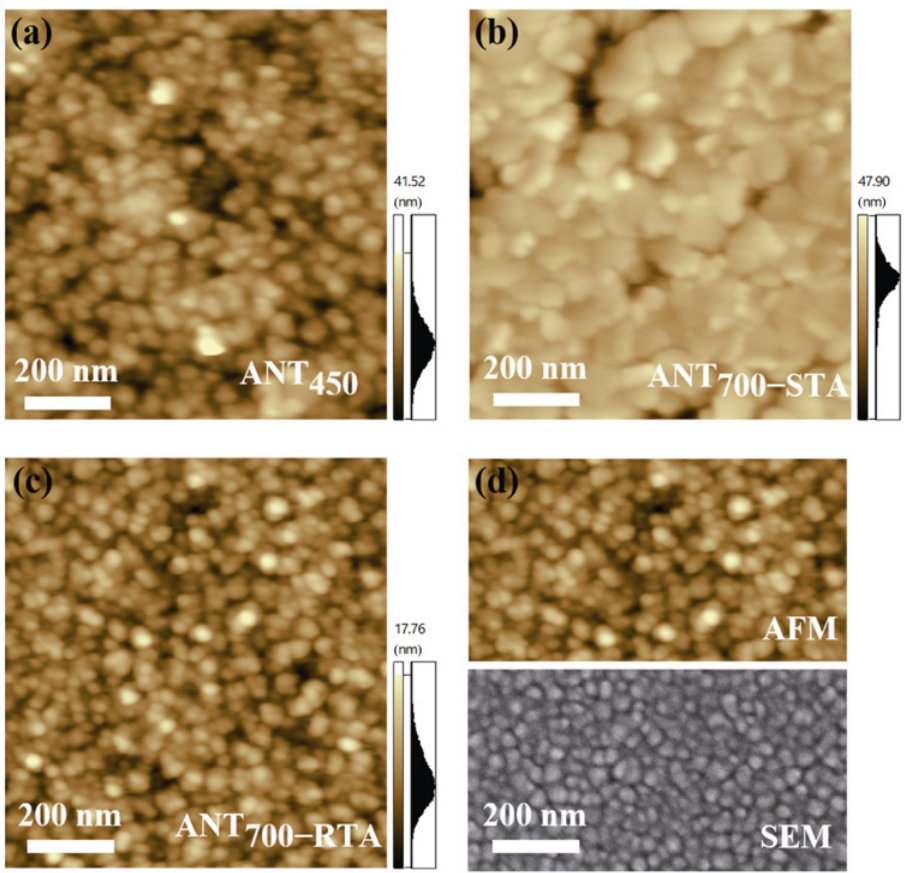
Fig. 3 AFM images of (a) ANT450, (b) ANT 700-STA , and (c) ANT 700-RTA films. (d) Comparison of AFM and SEM images for ANT 700-RTA films (with the same scale bar of 200